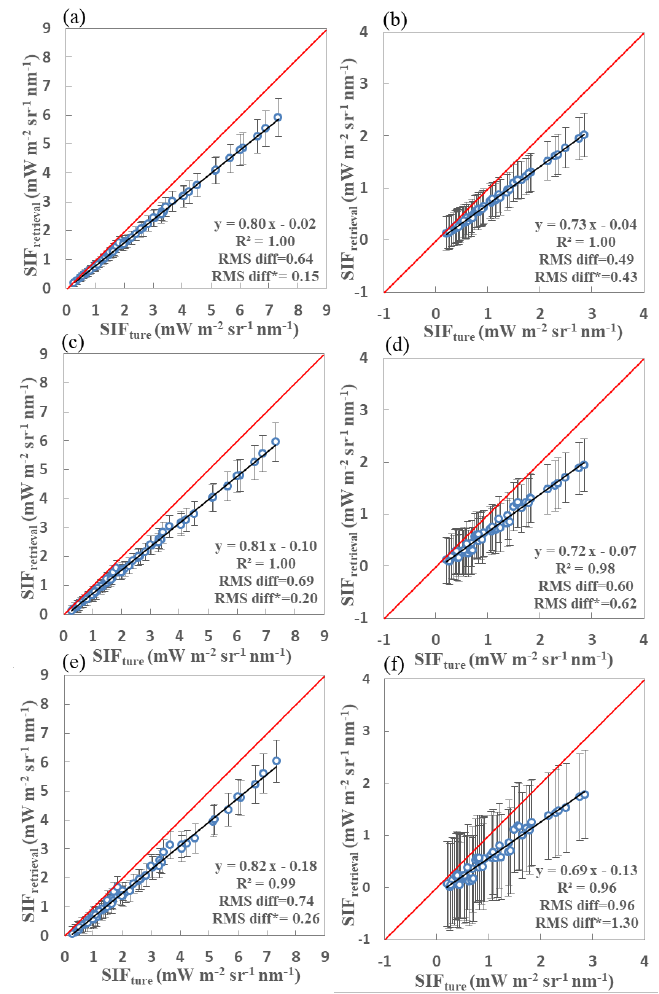
Figure 10. Retrieved vs. true fluorescence using far-red ( a , c , e ) and red ( b , d , f ) fitting windows derived from simulated data with an SNR of 127 and SR of 0.1 nm ( a , b ), SNR of 322 and SR of 0.3 nm ( c , d ), and SNR of 472 and SR of 0.5 nm ( e , f ). Standard deviations are also shown as vertical bars.